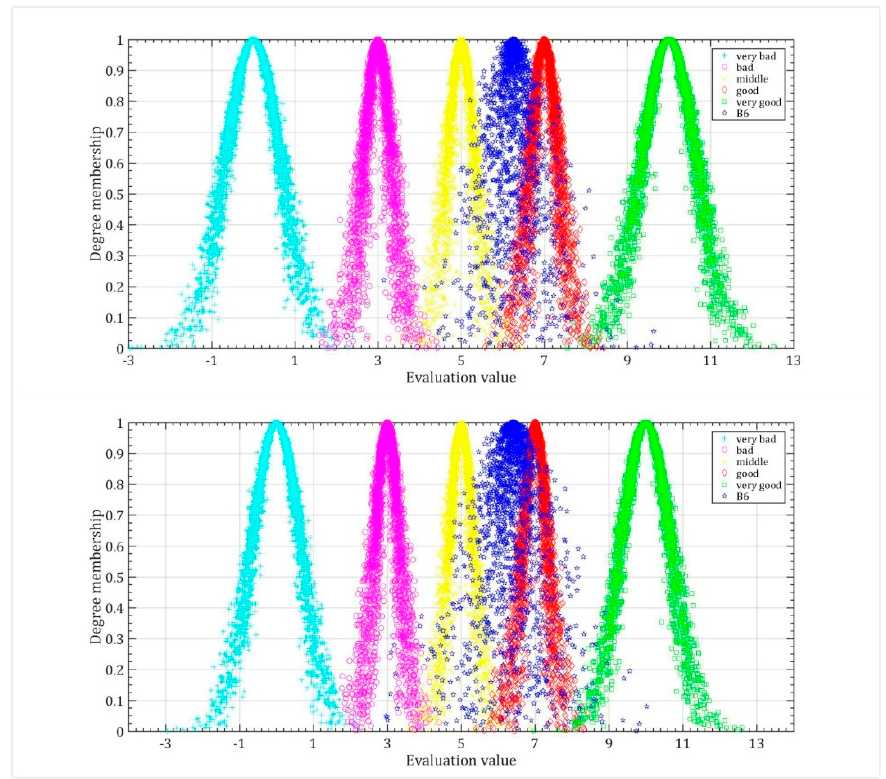
Figure 15. Cloud image of welfare evaluation grades of living conditions of land-lost farmers' households under different livelihood assets .